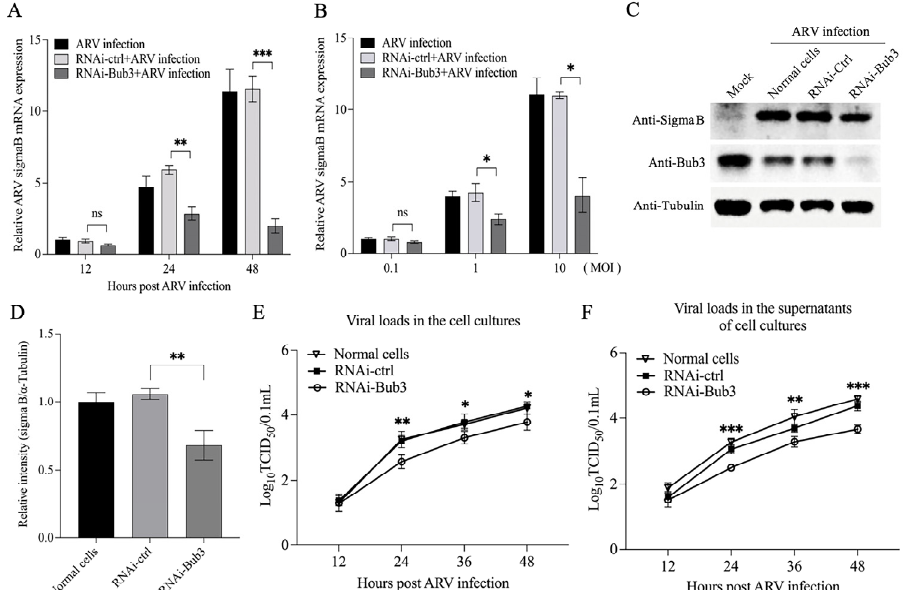
Figure 6. Effects of Bub3 on ARV growth in Vero-E6 cells. ( A ) Vero-E6 cells were transfected with RNAi-Bub3 or controls, followed by infection with ARV at an MOI of 1. At different time points (12 h, 24 h, and 48 h) post infection, the level of Sigma B mRNA was quantified. The relative level of Sigma B was calculated as follows: Sigma B expression / that of GAPDH expression. ( B ) Vero-E6 cells were transfected with RNAi-Bub3 or controls, followed by infection with ARV at an increased MOI of 0.1, 1 and 10. The level of Sigma B mRNA were quantified after twenty-four hours of ARV infection. ** stands for p < 0.01 and *** stands for p < 0.001. ( C , D ) Vero-E6 cells were transfected with RNAi-Bub3 or controls, followed by infection with ARV at an MOI of 10. Cell lysates were prepared at 24 h post infection and examined with Western Blot using indicated antibodies, and the band densities of Sigma B in ( C ) were quantitated by densitometry ( D ). Endogenous α -Tubulin expression was examined as an internal control. ( E , F ) Knockdown of Bub3 inhibited ARV replication. Vero-E6 cells were treated with RNAi to knock down endogenous Bub3 expression, followed by infection with ARV at an MOI of 1. At different time points (12 h, 24 h, 36 h and 48 h) post ARV infection, the viral loads in the cell cultures ( E ) or supernatants ( F ) were determined by TCID 50 analysis using 96-well plates. * stands for p < 0.05, ** stands for p < 0.01 and *** stands for p < 0.001. Taken together, our data showed that ARV p17 triggered the cell-cycle perturbation